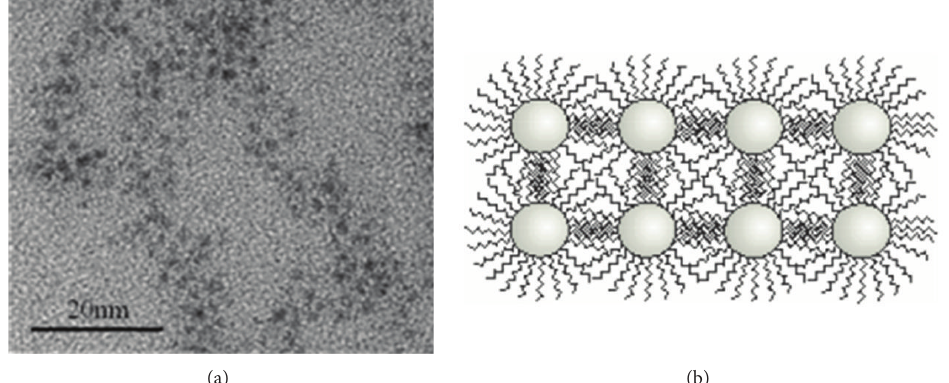
Figure 2: TEM-micrograph of dodecyl-thiolate derivatized Au clusters (a) and schematic representation of the aggregate formation by the alkyl-chain interdigitation process